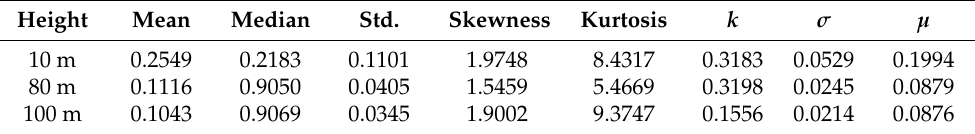
Table 2. Statistic results of the turbulence intensities.